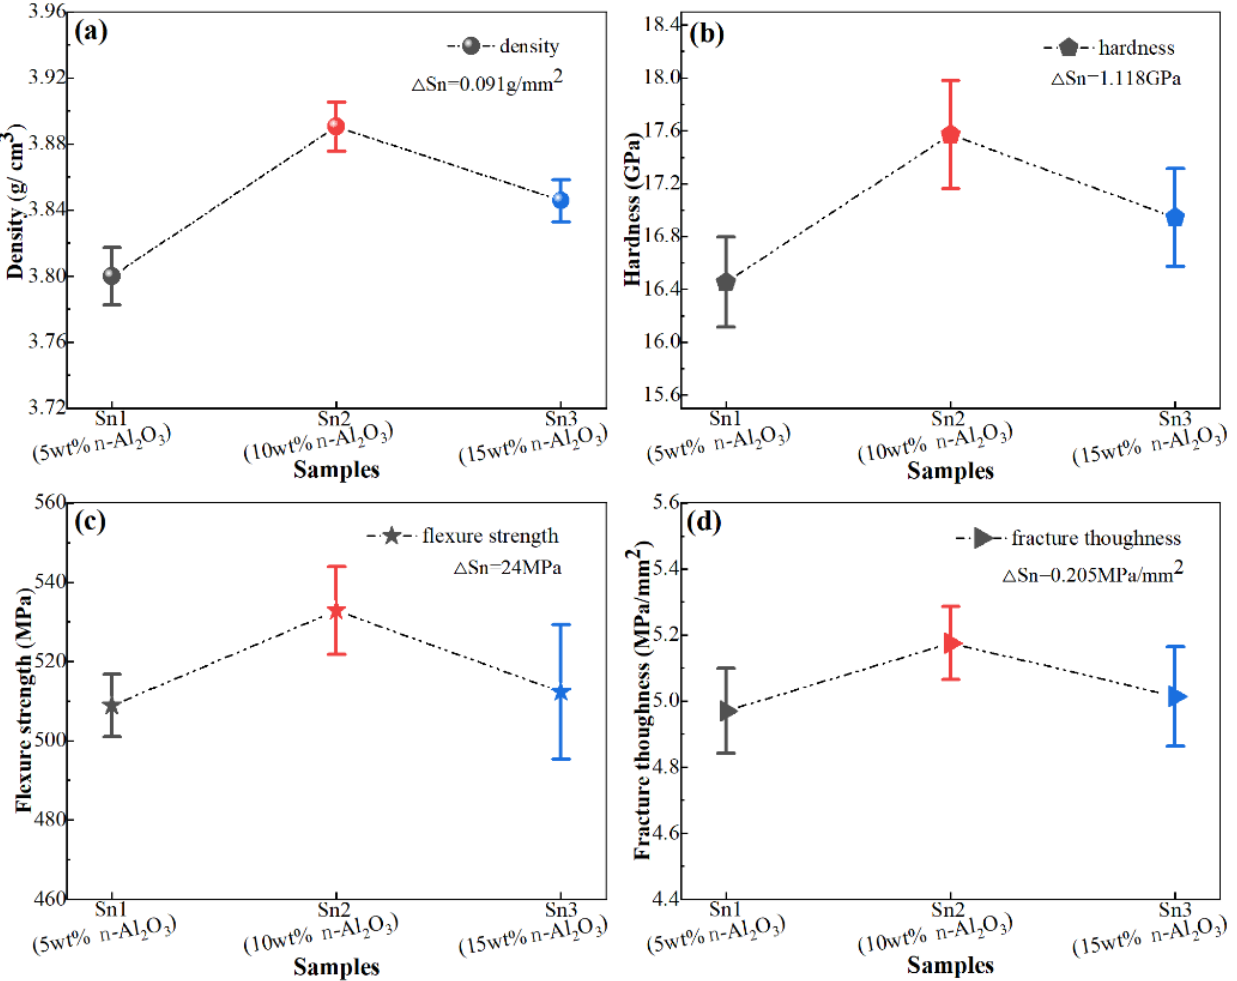
Figure 2. The effects of n-Al 2 O 3 on the properties of Al 2 O 3 composite ceramics: ( a ) density, ( b ) hardness, ( c ) flexure strength, ( d ) fracture toughness.